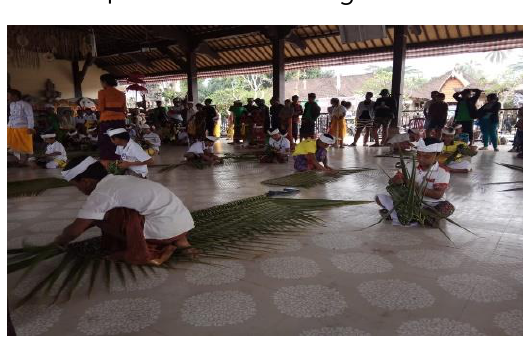
Figure 2 Hindu Teenage of Taro Village follows the Dharmagita competition